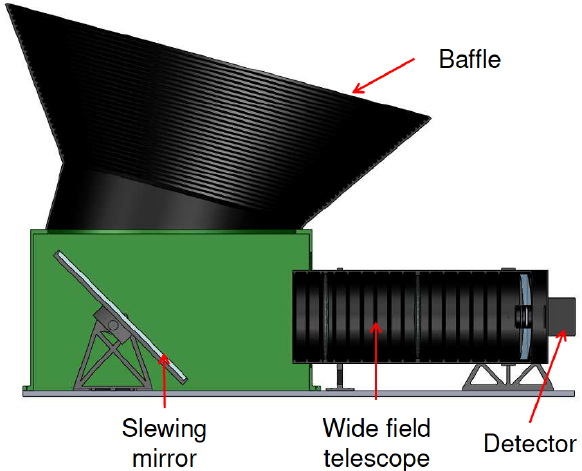
Figure 3. The concept of SODA wide field telescope with slewing